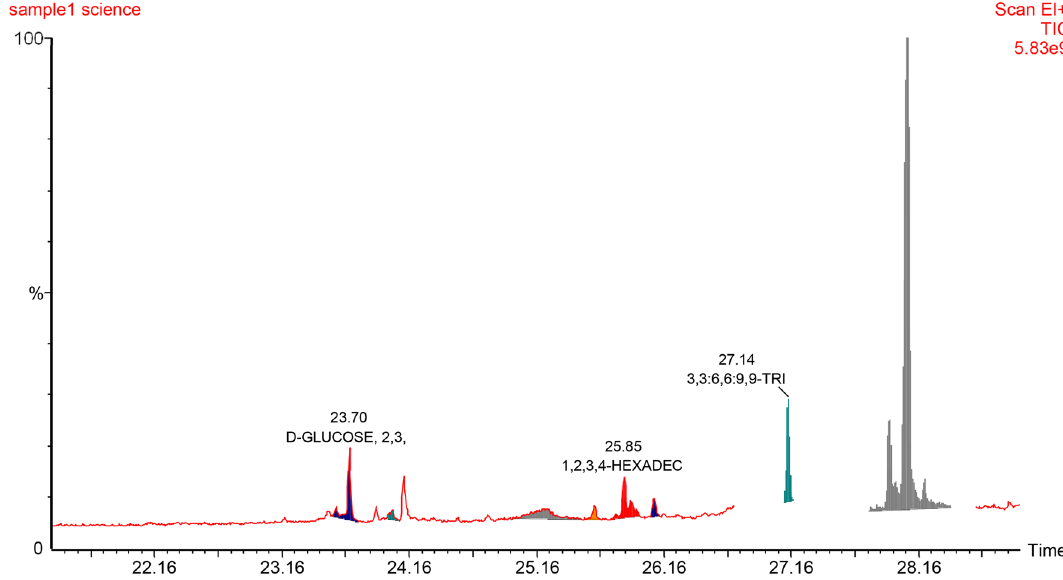
Figure 7. GC–MS analysis chromatograms of non-treated callus of J. procera.